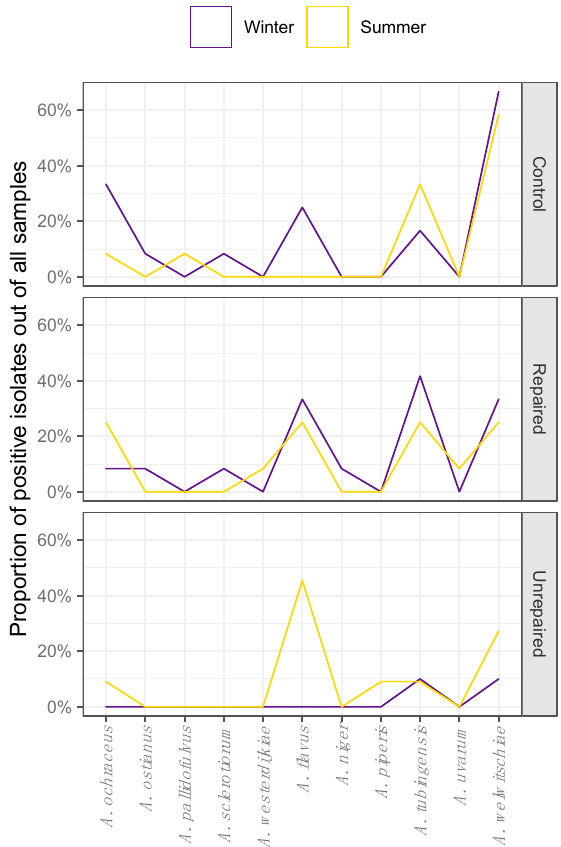
Figure 4. Seasonal distribution patterns of Aspergilli from the sections Circumdati ( A. ochraceus , A. ostianus , A. pallidofulvus , A. sclerotiorum , and A. westerdijkiae ), Flavi ( A. flavus ) and Nigri ( A. niger , A. piperis , A. tubingensis , A. uvarum , and A. welwitschiae ) in dust collected during winter and summer sampling periods in repaired houses, unrepaired houses, and control houses.